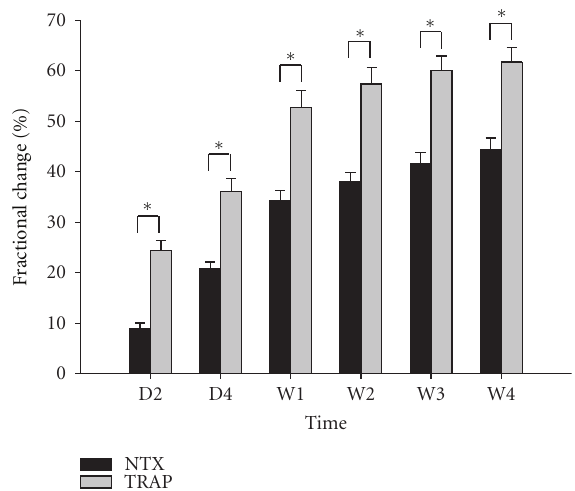
Figure 3: Magnitude of changes in values for serum cross-linked N-telopeptide of type I collagen (NTX) and tartrate-resistant acid phosphatase 5b (TRAP) expressed as mean percent change com- pared to baseline at 1 day (D2), 3 days (D4), 1 week (W1), 2 weeks (W2), 3 weeks (W3), and 4 weeks (W4) after parathyroidectomy for secondary hyperparathyroidism. ∗ P < 0 . 001 by the Mann-Whitney Rank Sum